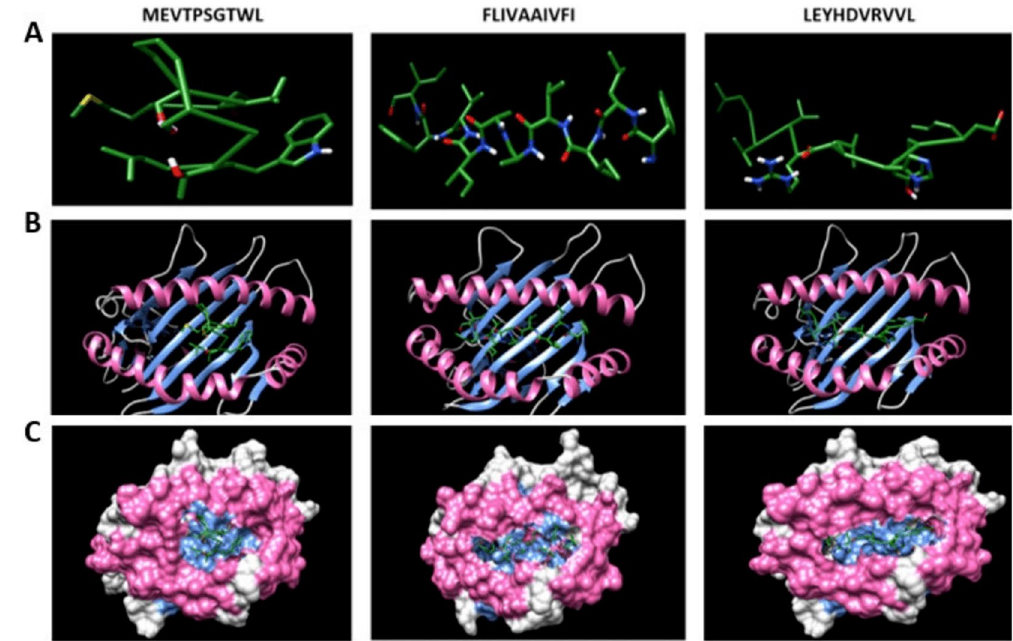
Figure 3. ( A ) Predicted MEVTPSGTWL, FLIVAAIVFI and LEYHDVRVVL epitopes docking to MHC-I alleles. ( B ) Docking results of epitopes with α chain of MHC-I alleles using ClusPro. ( C ) The snapshot representing the epitope docked in the pocket of molecular surface of the receptor (all the structures are visualised using Chimera